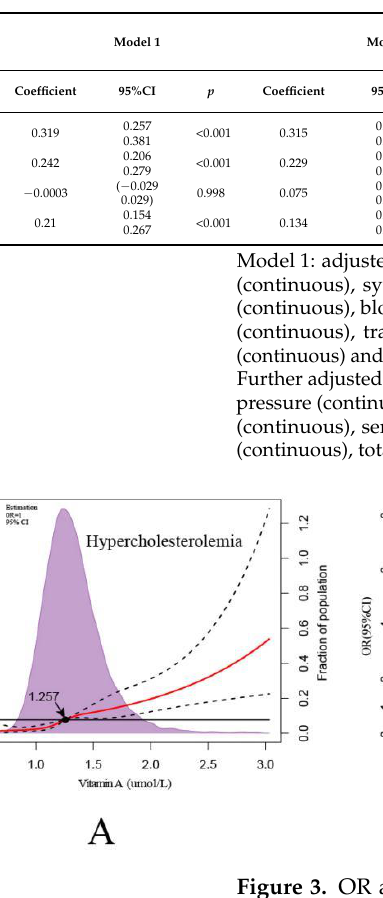
Table 4. Multi-variable associations of vitamin A with Blood lipid in children in Shandong province.